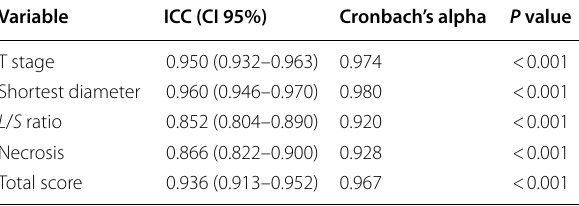
Table 5 Intraclass correlation coefficient between the 2 observers of different items and total score of the scoring